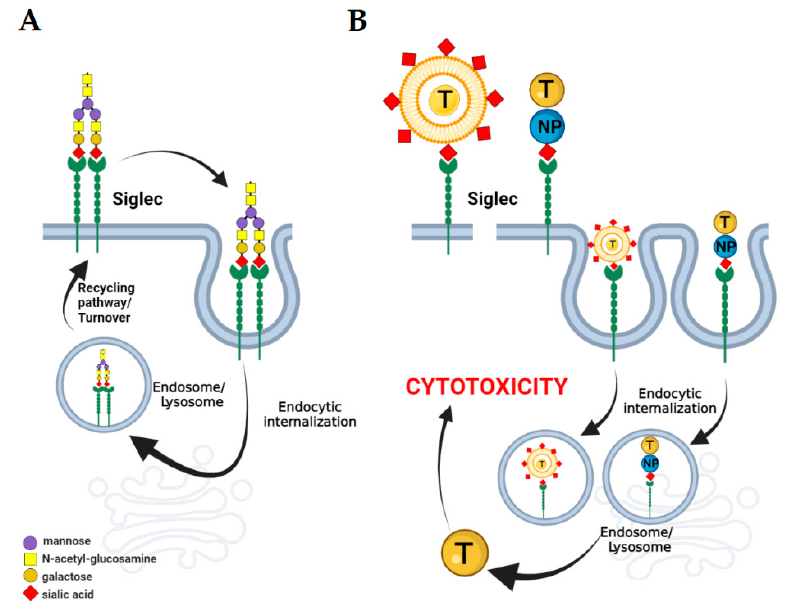
Figure 3. The endocytosis-based mechanism of action of sialic acid-decorated nanomaterials. Most Siglecs undergo endocytosis following binding with specific sialylated ligand. The endocytic uptake and recycling pathway control the structure of plasma membrane and related cellular activity ( A ).